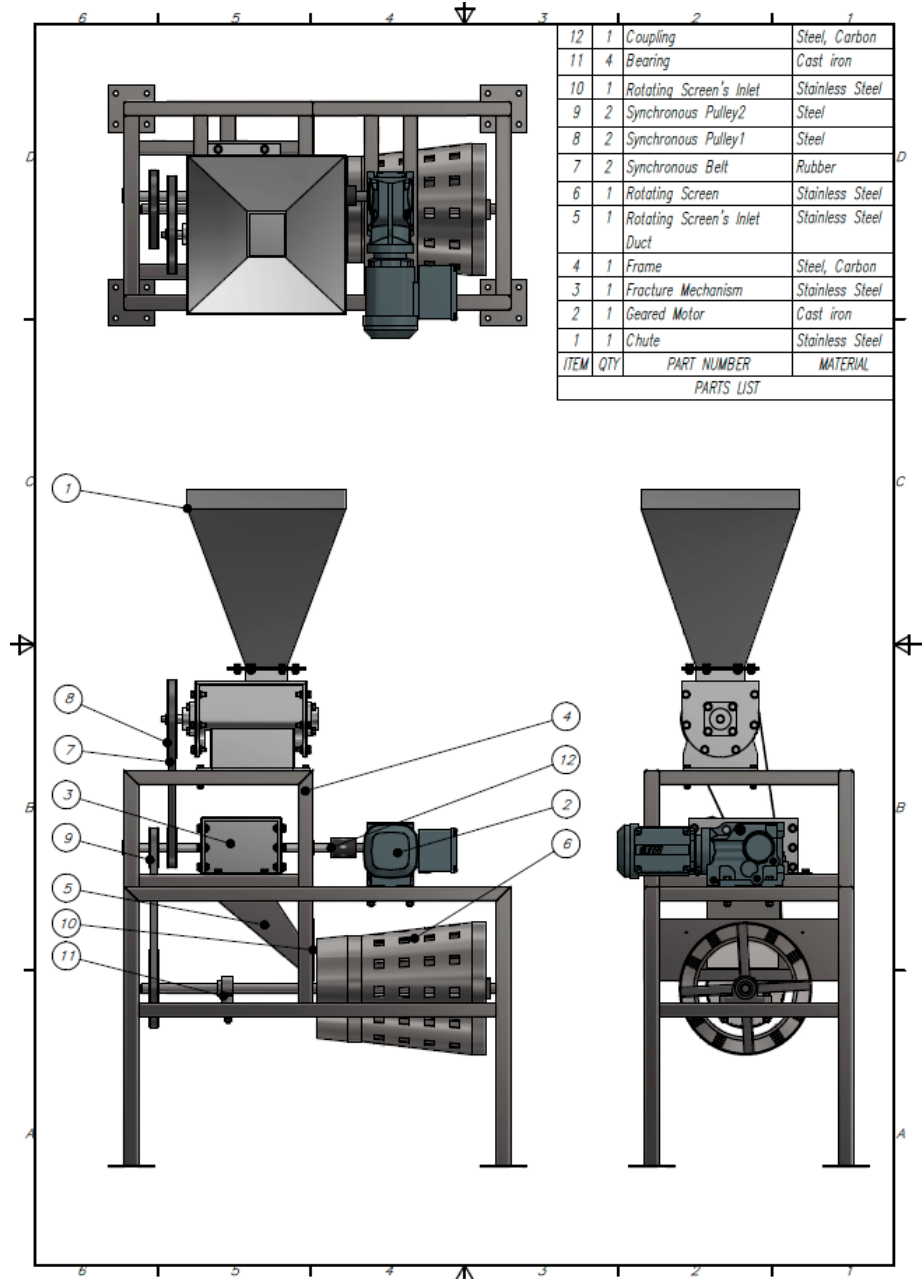
Figure 13. Assembly plan of the shell cracking machine and its elements: main views.